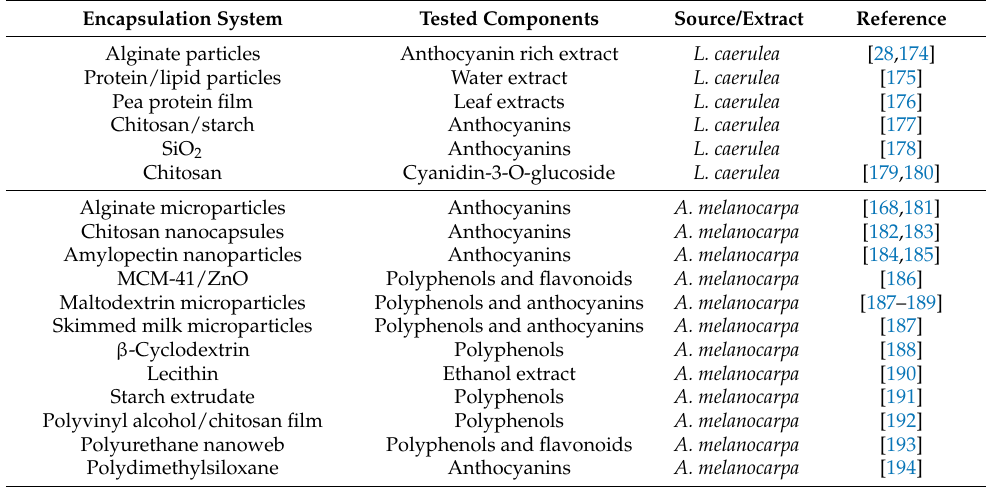
Table 1. Controlled release systems with active substances available in A. melanocarpa and L. caerulea